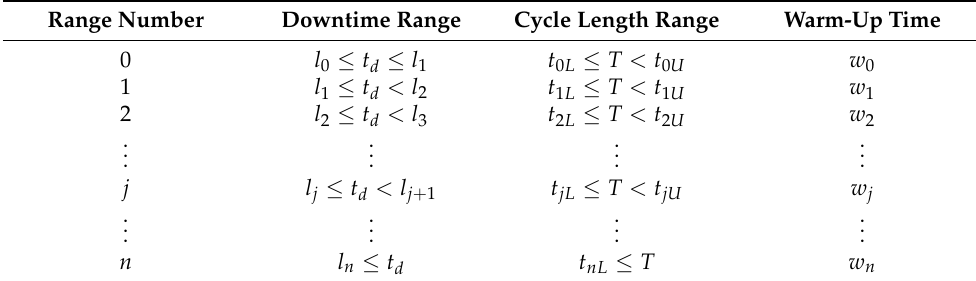
Table 3. Warm-up time diagram based on the cycle